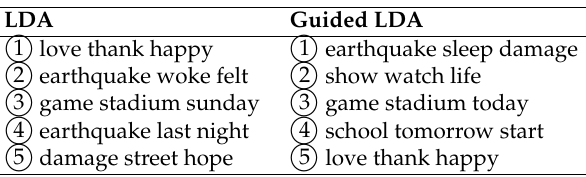
Table 1. Fictitious example to illustrate the output of a normal, unseeded (left) and a guided LDA (right). The five topics could be detected by a topic model in a dataset containing Tweets related to an earthquake. Note that for guided LDA, all earthquake-related terms are in a single topic 1 (cid:13) , whereas the event is covered in the topics 2 (cid:13) , 4 (cid:13) , 5 (cid:13) by the LDA. LDA Guided